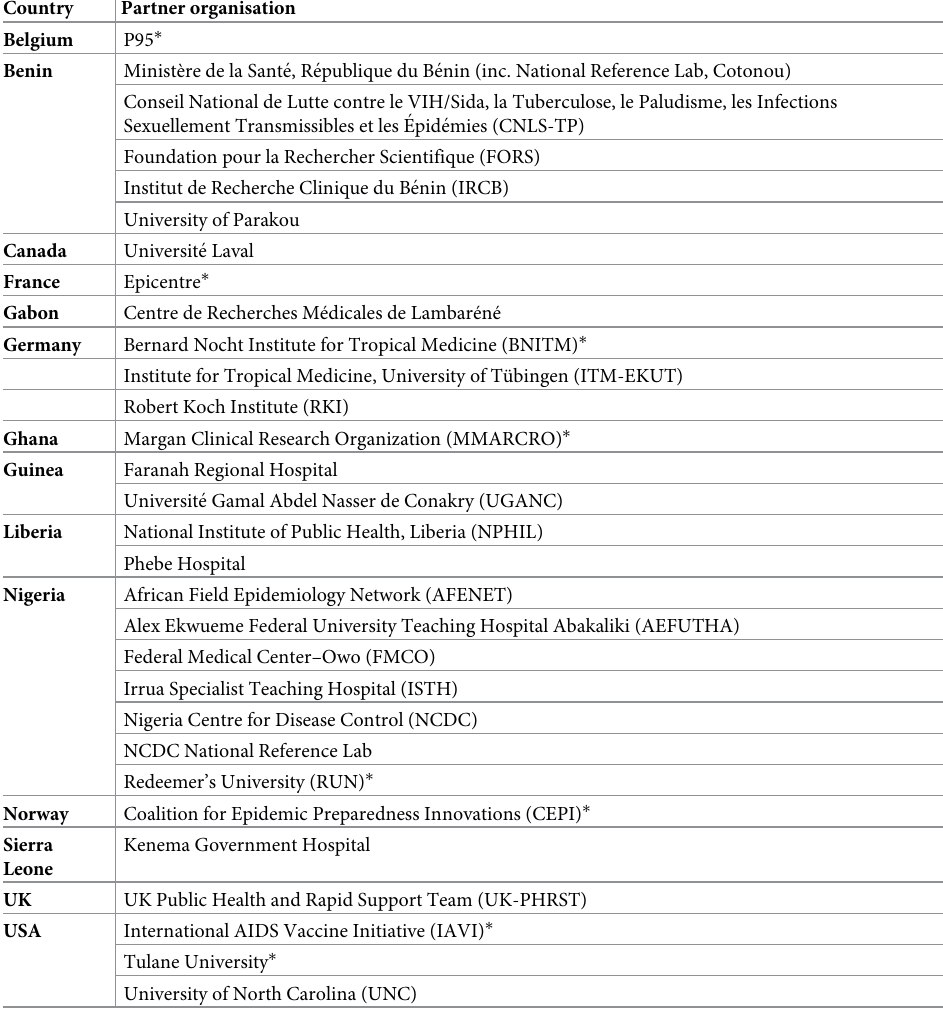
Table 4. List of Enable Lassa research programme partners by country. Partner organisations are listed in alphabet- ical order per country.